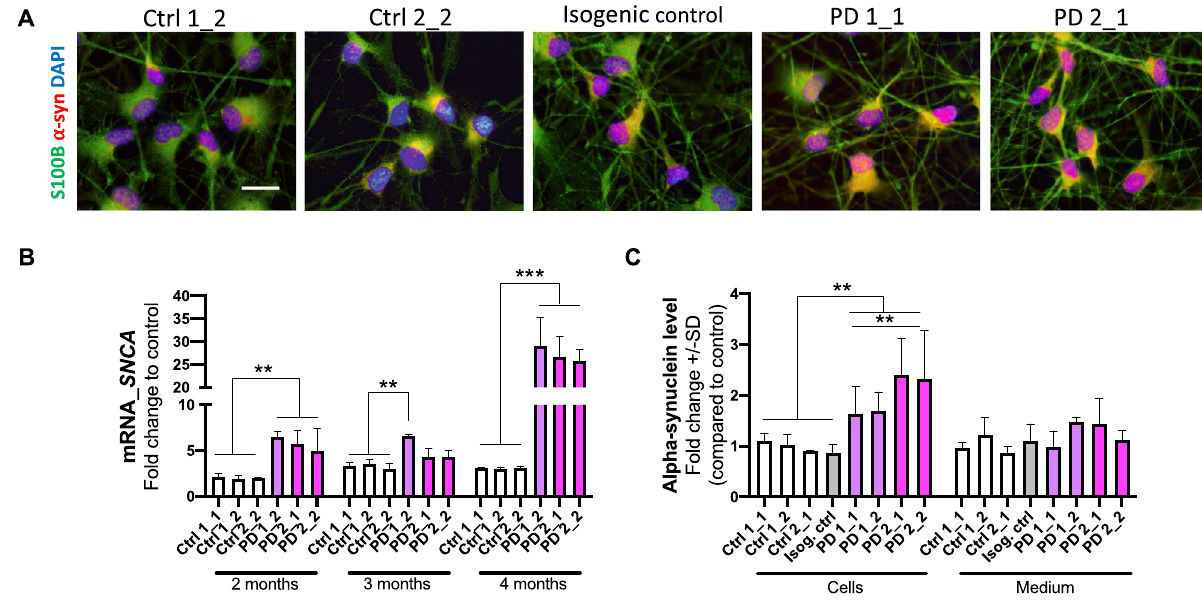
mean ± SD, **p < 0.01, ***p <